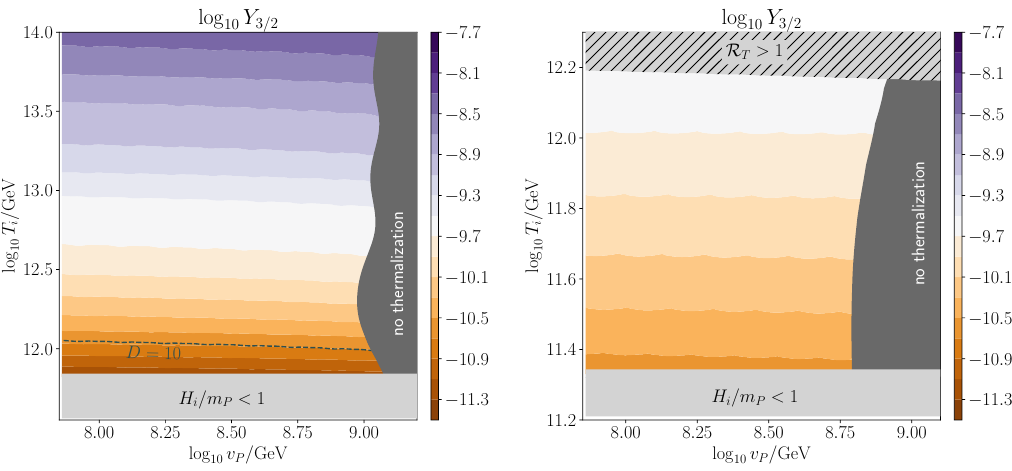
= 10 5 GeV ) scenario on P